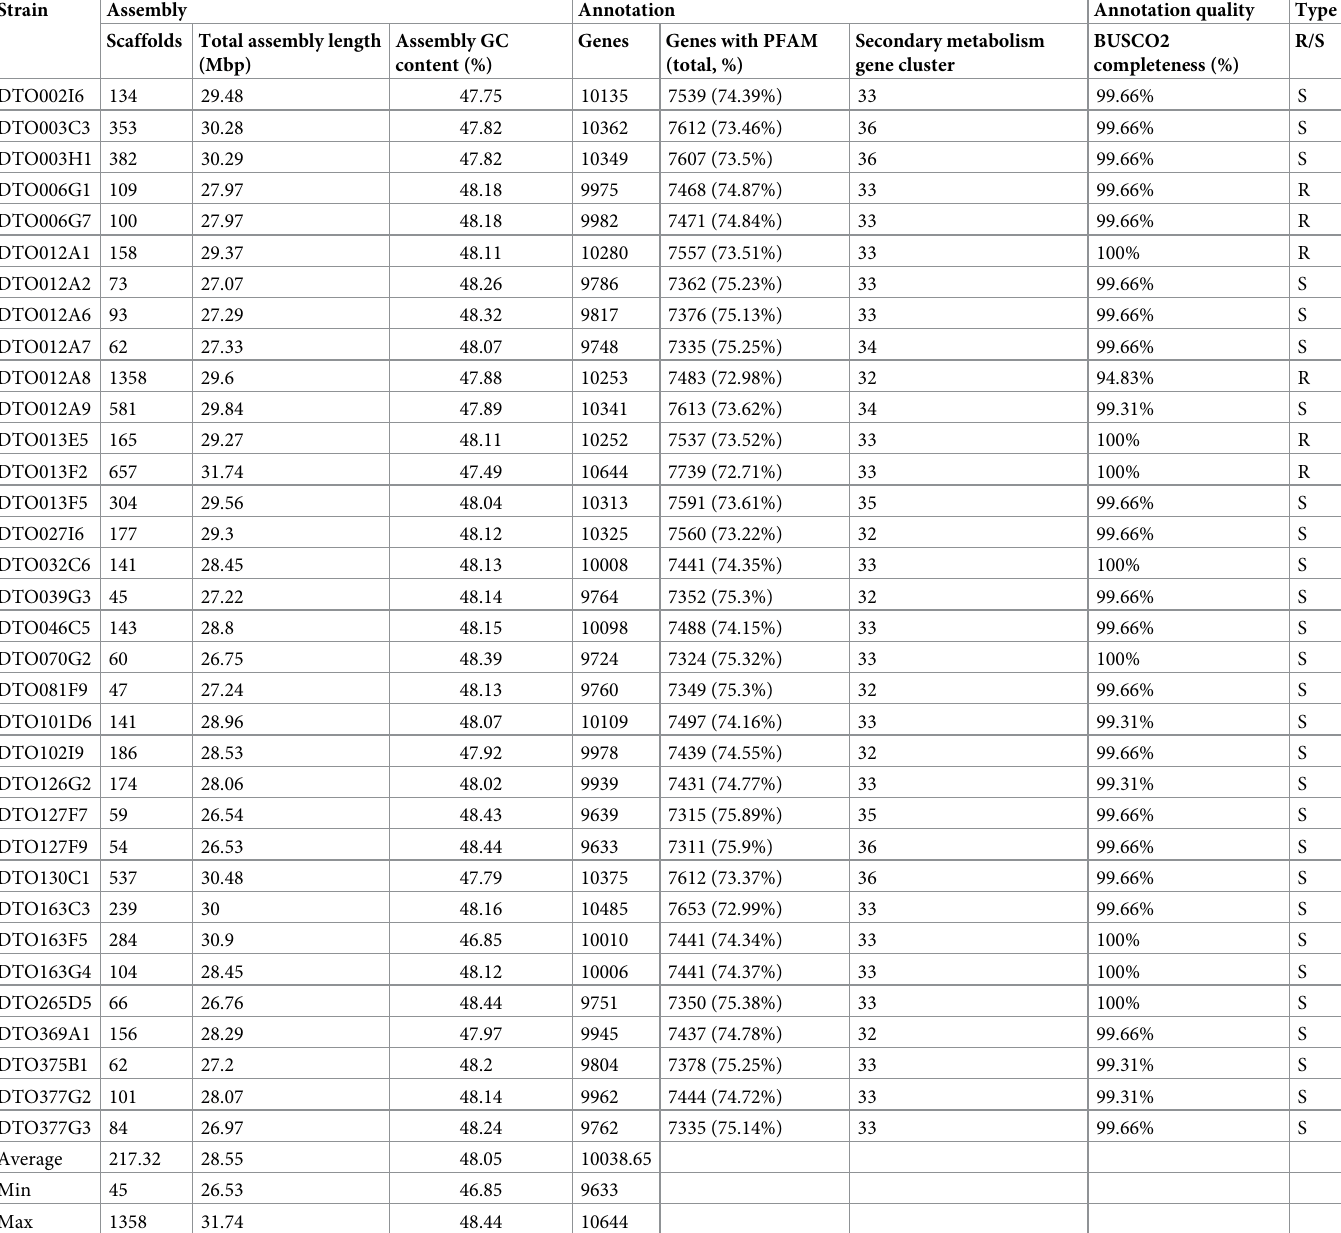
Table 1. Genome assembly and annotation statistics. The number of scaffolds, assembly length, GC content and genes of the 34 sequenced P . roqueforti strains are listed. In addition, the number of genes with a PFAM domain, the number of secondary metabolism gene clusters and the BUSCO completeness are listed. The type column indi- cates if the strain is sorbic acid-resistant (R) or sorbic acid-sensitive (S). Strain Assembly